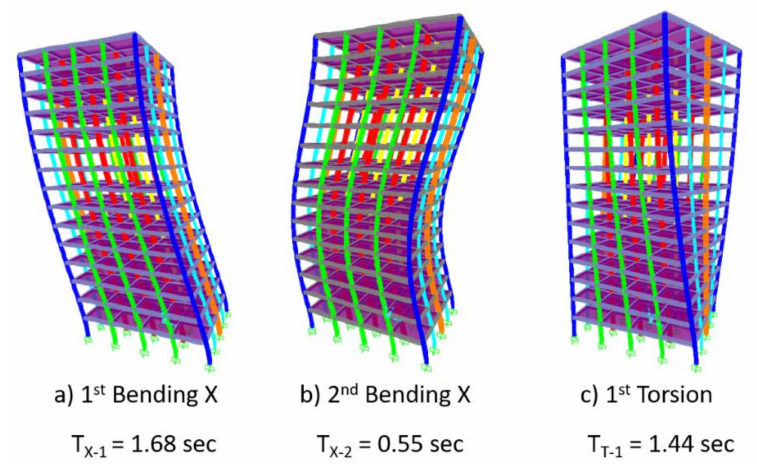
Figure 10. Vibration modes and periods of the analyzed system ( a ) the 1st bending mode in X